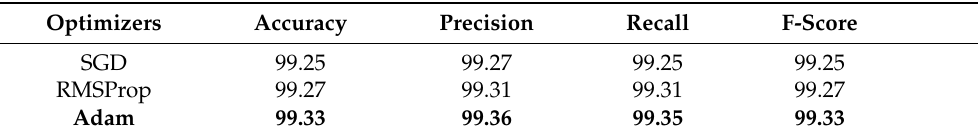
Table 2. Average recognition performance of the proposed convolutional neural network with the ReLU activation function and different optimization methods on the KGB dataset. The best performance is shown in bold.